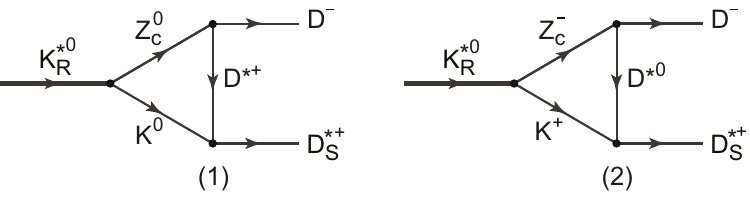
Figure 7 . Contributions associated with the diagram (b) of (cid:12)gure 2 for the decay mechanism K (cid:3) 0 ! D (cid:0) D (cid:3) + s R